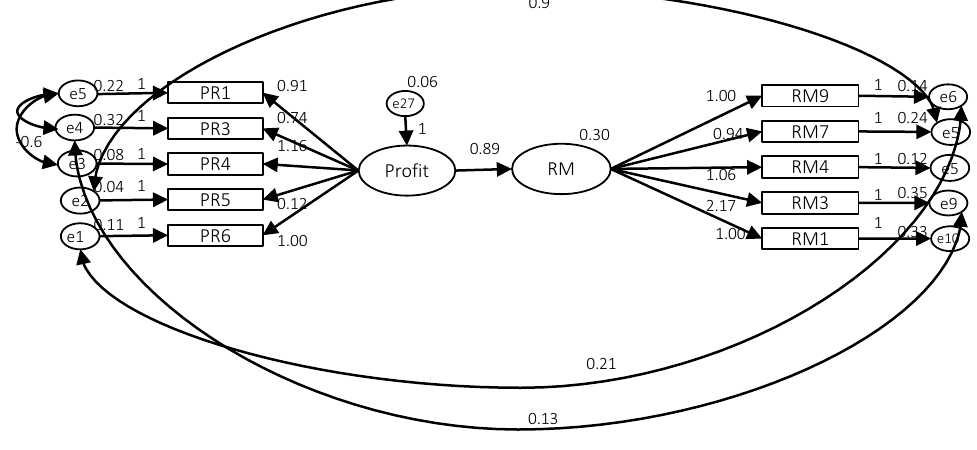
Figure 4. Structural model 3